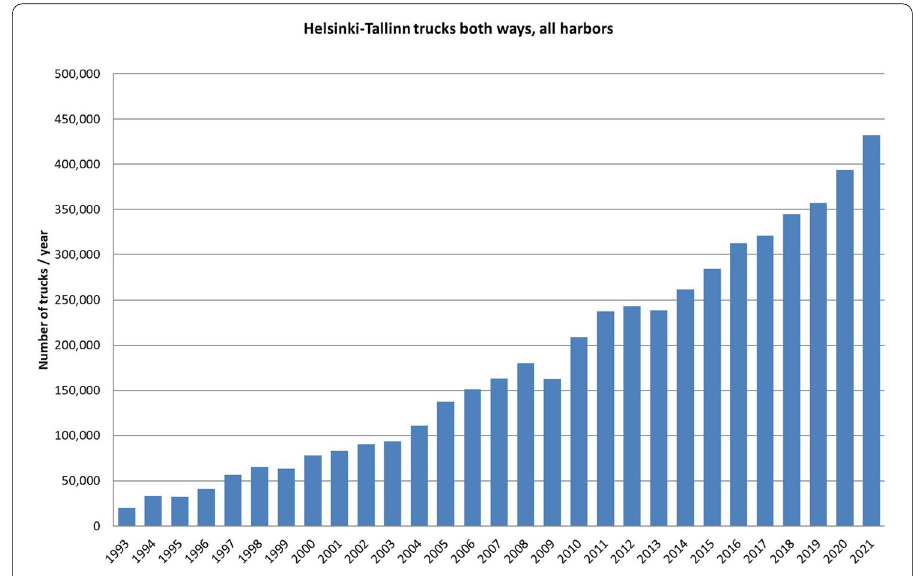
Fig. 3 Truck traffic between Port of Helsinki and Port of Tallinn (units, all harbours, both ways). Source : Traficom (2011–2022) and its predecessors—author’s own compilation